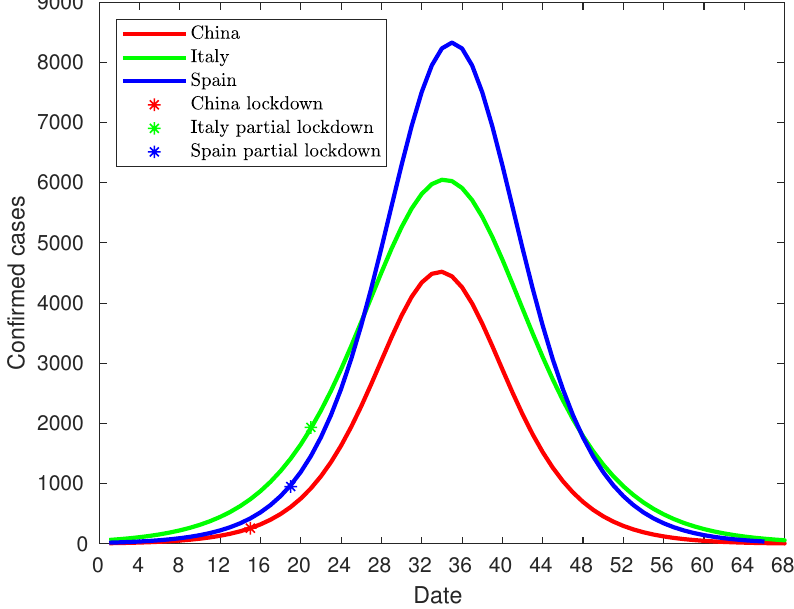
Figure 17. Number of daily diagnosed cases